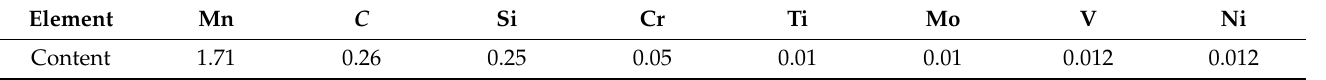
Table 1. Chemical composition of cathode material P110 steel